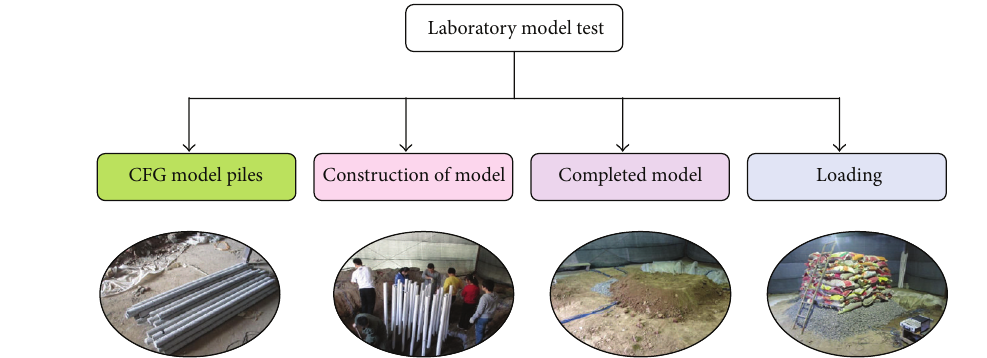
Figure 16: Construction of laboratory model test [25].